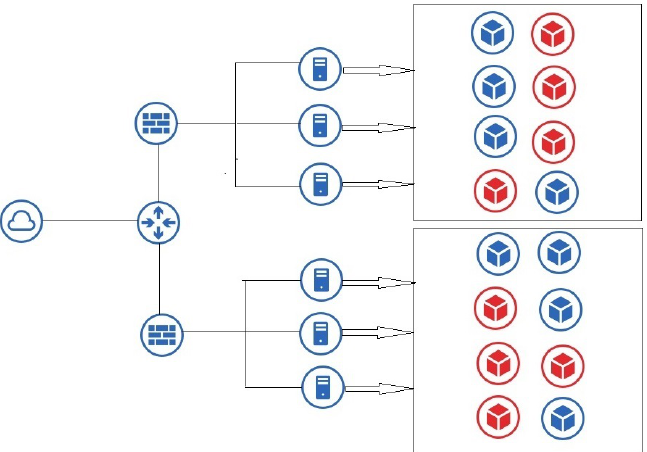
Figure 2. System model